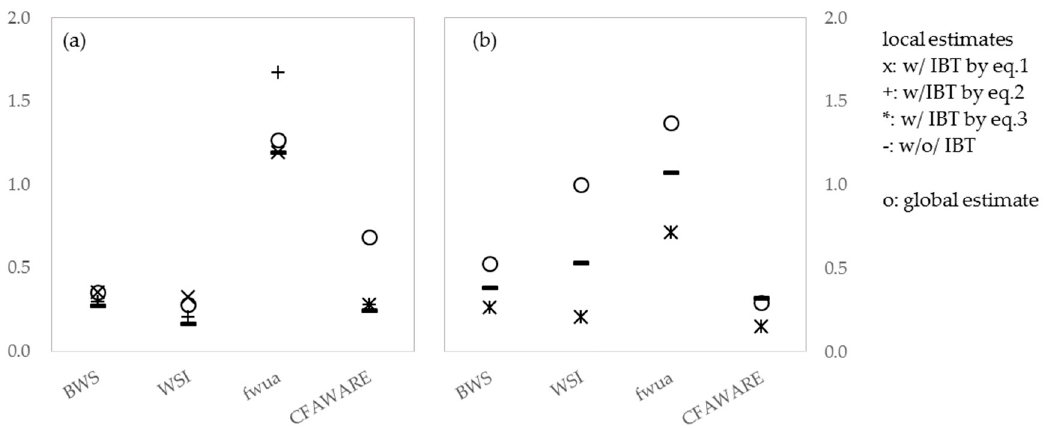
Figure 3. Estimated local and global results of each characterization factor with and without IBT for ( a ) the Tone river basin, ( b ) the Arakawa river basin.